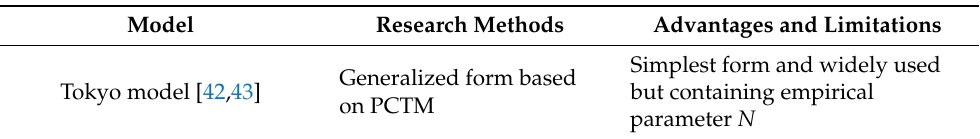
Table 3. Research methods, advantages, and limitations of reservoir simulator used models for permeability prediction of